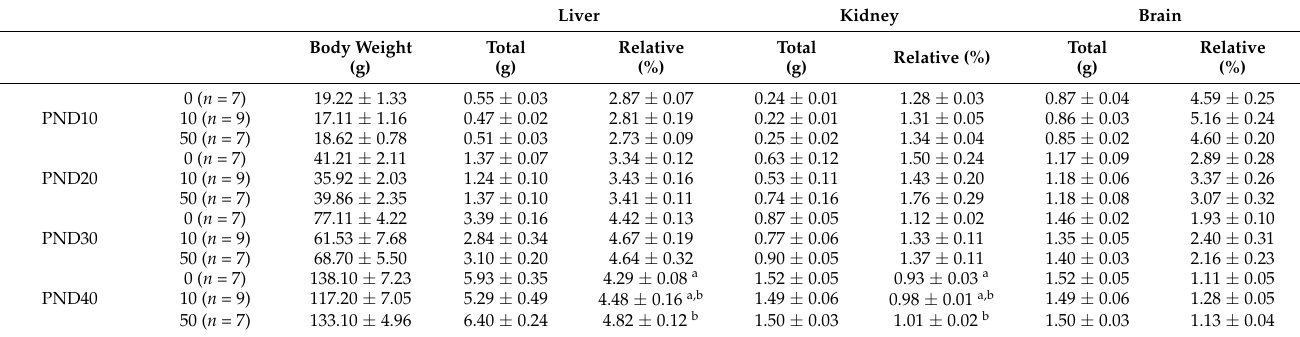
Table 3. Organs total and relative weight of pups exposed to inorganic Hg in utero and via milk from dams exposed to different doses (0, 10, and 50 µ g Hg 2+ /mL) of HgCl 2 in drinking water during the pregnancy and lactation period. Liver Kidney Brain Body Weight Total Relative Total (g) (g) (%) (g) Relative (%)